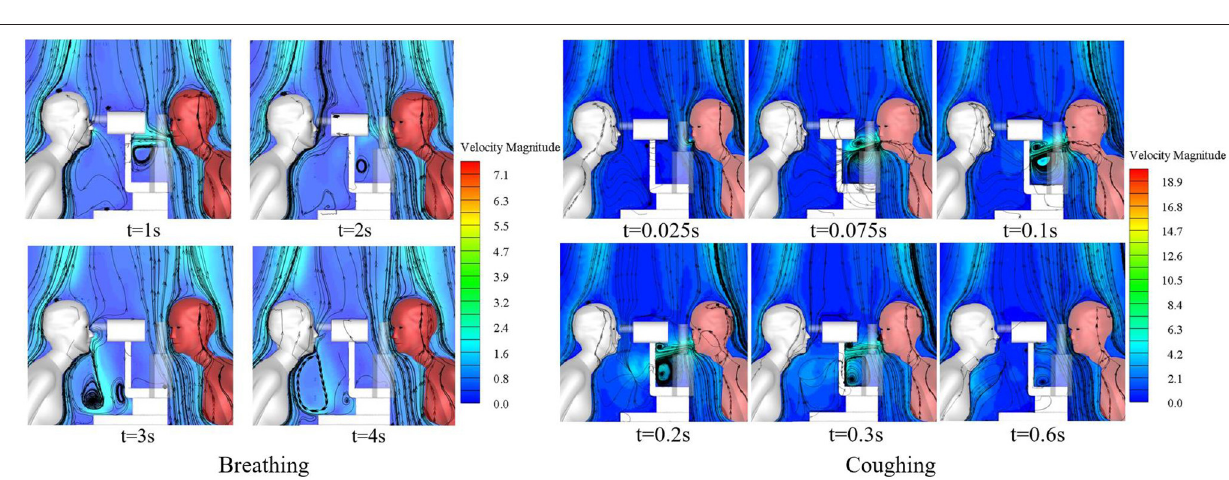
FIGURE 4 | Sites of ophthalmologists’ exposure during three ophthalmic examination or treatment scenarios.